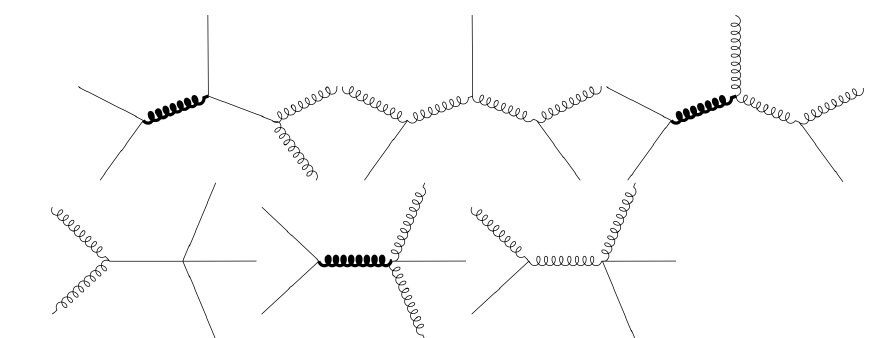
Figure 12 . The six types of diagrams for φ φ φAA process. The bold curly line represents a gluon and the straight line a scalar